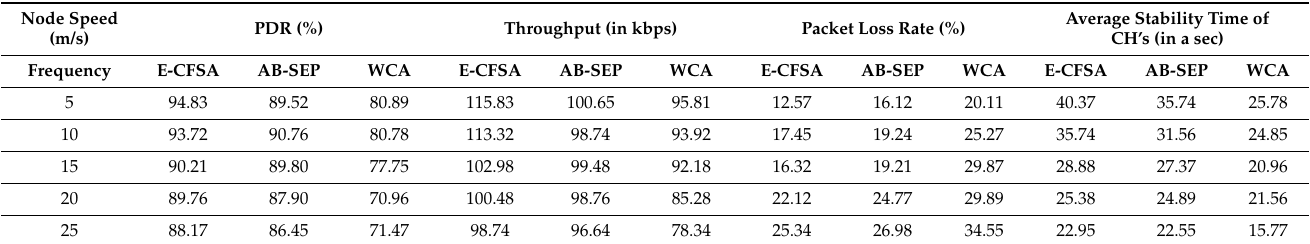
Table 8. Simulation results (impact of Node